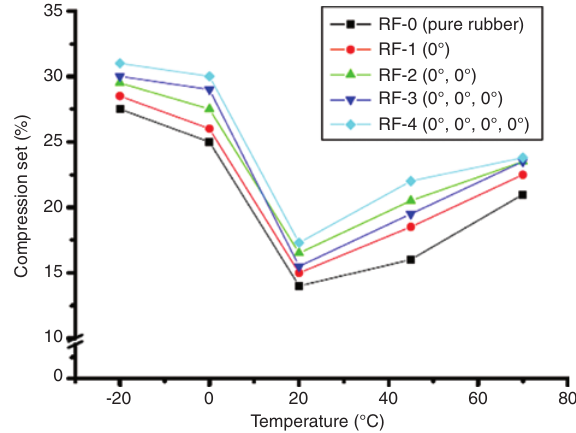
Figure 4: Compression set of CR reinforced with different numbers of polyester tire cord layers at varied